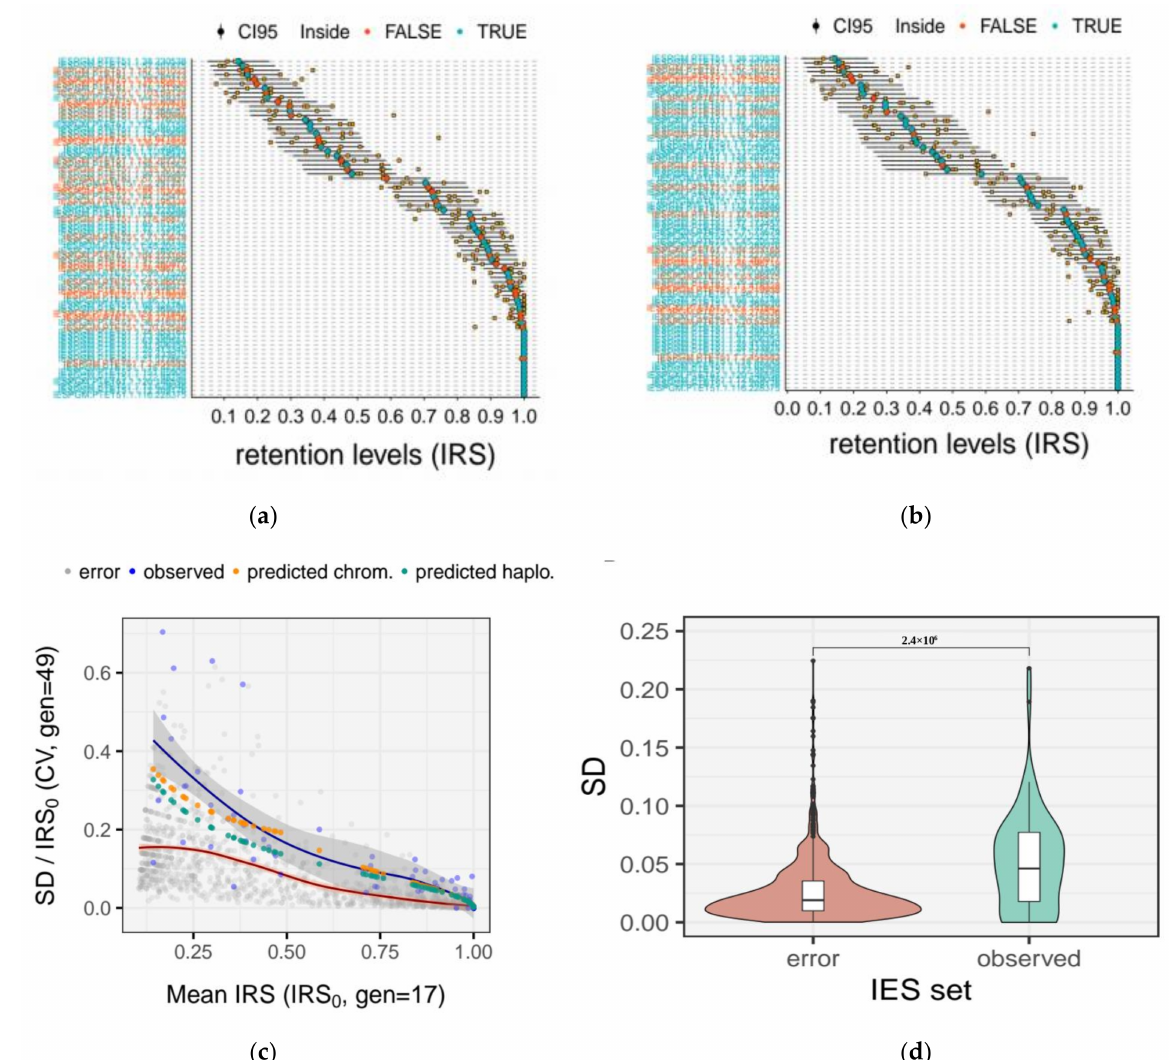
Figure 6. Comparison of observed and theoretical variation of IES retention levels ~50 amitotic divisions post self- fertilization. ( a ) Haploid model . The empirical distribution of IES retention levels is compared to the theoretical distribution predicted by the haploid model (random assortment of haploid whole-genome subunits); ( b ) Chromosomal model . The empirical distribution of IES retention levels is compared to the theoretical distribution predicted by the chromosomal model (random assortment of chromosomes). Retention levels (orange-filled squares) were measured experimentally with scDNA sequencing 14 days post autogamy (D14, n = 3) for a selected set of highly covered (>20 reads) somatic loci (“track set”, N = 75). Horizontal black bars represent the theoretical 95% Confidence Interval (CI) constructed on the mean retention levels (IRS 0 , large red- or green-filled circles) measured 5 days post autogamy (D5, n = 4), ~31 asexual generations prior. Filled circles (IRS 0 ) are colored in green when the experimentally determined retention level lies inside the 95% CI for all three replicates and red otherwise. IRS, IES retention score; ( c ) observed relative variation of IRSs 14 days post self-fertilization. For each IES, the coefficient of variation of the IRSs measured on day 14 (SD IRS /IRS 0 , gen = 49) is